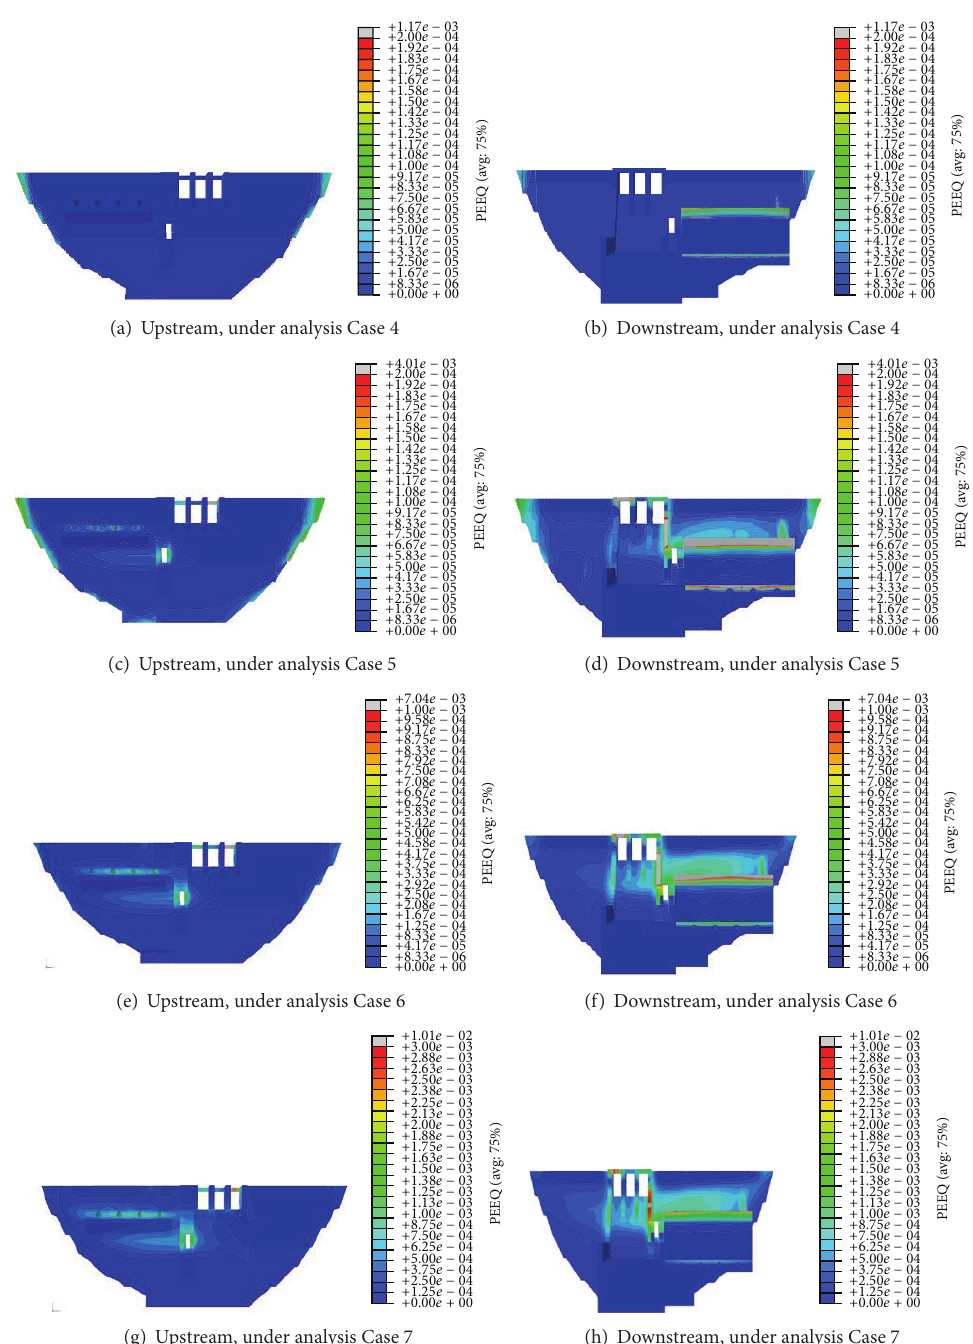
Figure 8: Dam upstream/downstream yield zone under various analysis